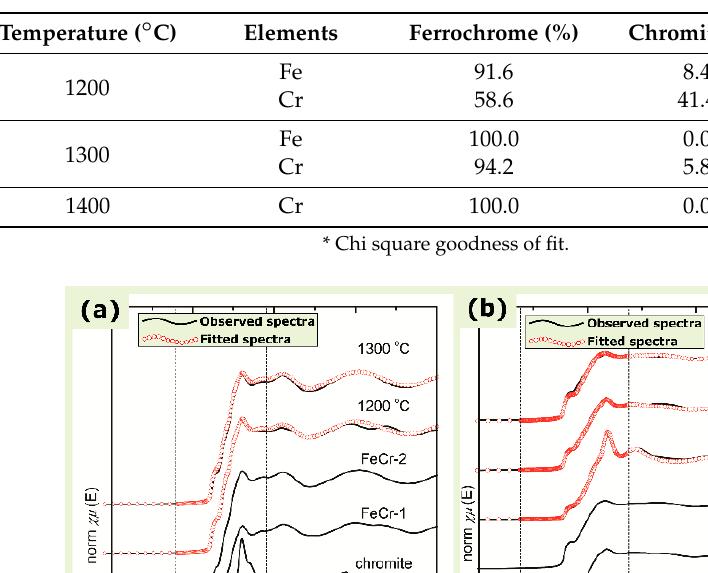
Table 2. Elemental distribution of Fe and Cr in the ferrochrome alloy and the residual chromite phases, produced from least-square fitting of the X-ray absorption spectra as shown in Figure 9.